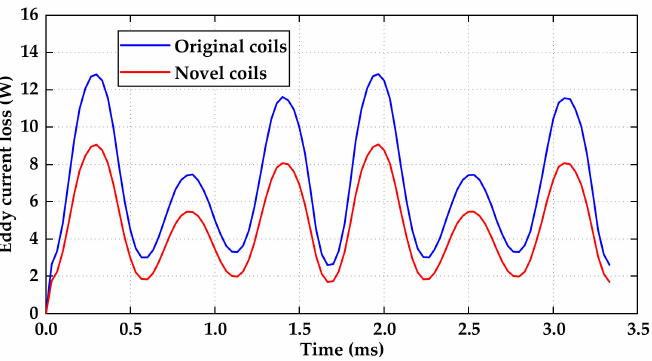
Figure 13. Comparison of eddy current loss between the original and novel